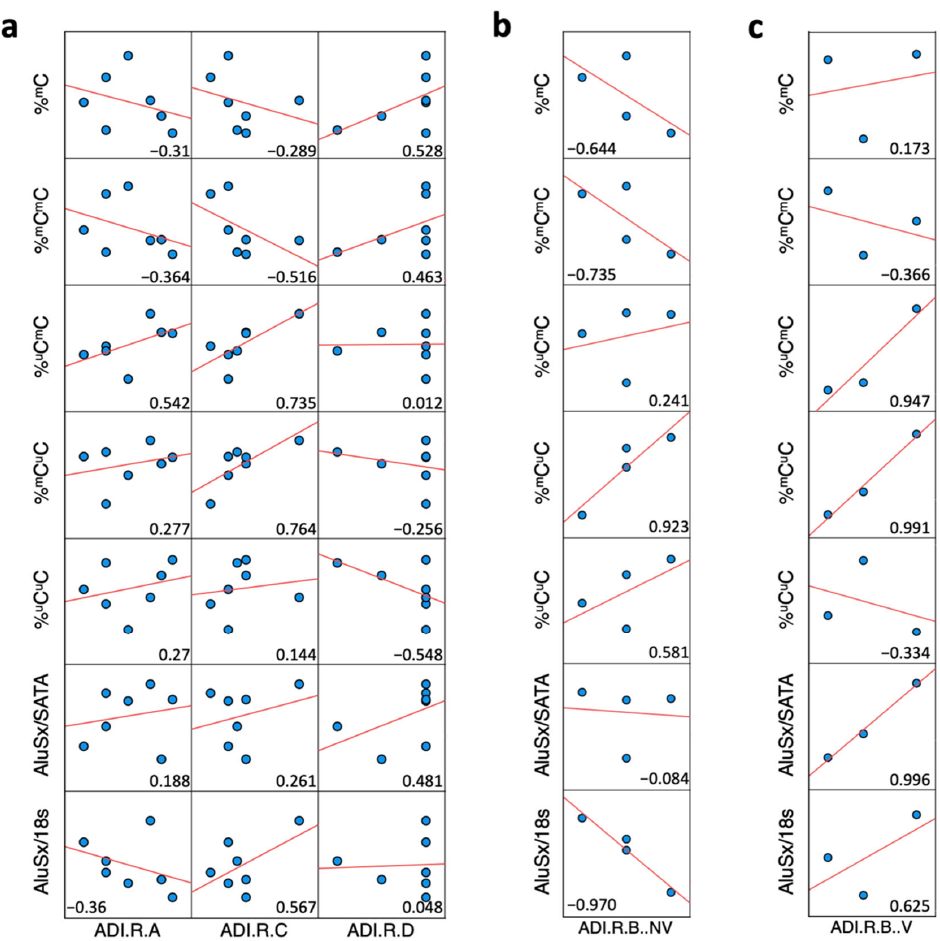
Figure 7. Correlation matrix between ADI-R score and DNA methylation, expression, and relative copy number of Alu elements in the prefrontal cortex: ( a ) Correlation between Alu elements and ADI-R A, social interaction; ADI-R C, restricted, repetitive, and stereotyped patterns of behavior; and ADI-R D, abnormality of development evident at or before 36 months. ( b ) Correlation between Alu elements and ADI-R B; nonverbal communication. ( c ) Correlation between Alu elements and ADI-R B; verbal communication. Red lines represent trend lines (linear model) and blue points represent ASD individuals.